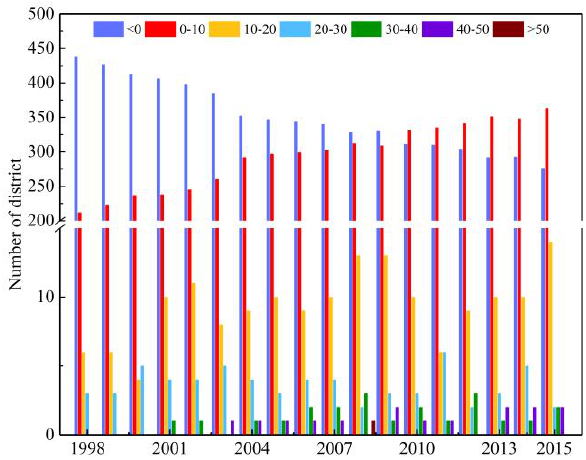
Figure 4. Districts of D PM Figure 4 showed statistics of D PM number of districts with D PM increasing trend, especially the number of districts with D PM between 0 and 10. However, the amount of districts with D PM